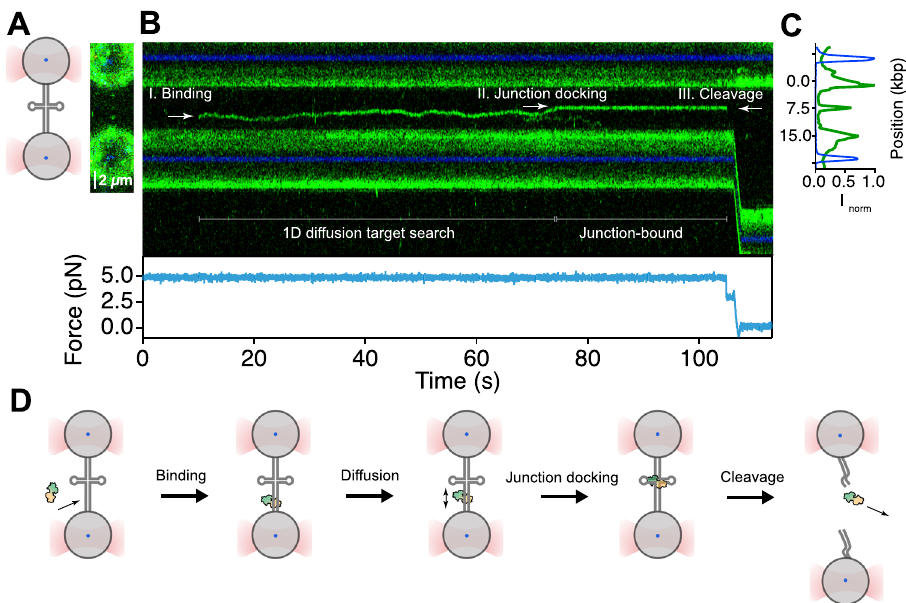
Fig. 2 | A complete reaction trajectory in which endonuclease I diffuses on the dsDNA until it encounters and cleaves a four-way junction. A Left panel : Sche- matic of the dumbbell assembly. The DNA with a four-way junction at its centre is tethered between optically trapped beads. Right panel: A confocal image of the dumbbell with endonuclease I (green dots) bound to the DNA (unlabelled). B A stack of frames (kymograph) recorded by continuous confocal scanning along the DNAaxis.CorrespondingforceexertedontheDNA,plottedbelow,iskeptconstant by a feedback loop mechanism and decreases to 0pN upon DNA cleavage. The intermediate force level at 3pN is likely an artifact from the force feedback loop mechanism, and is not observed in other kymographs (Supplementary Fig. 5). The